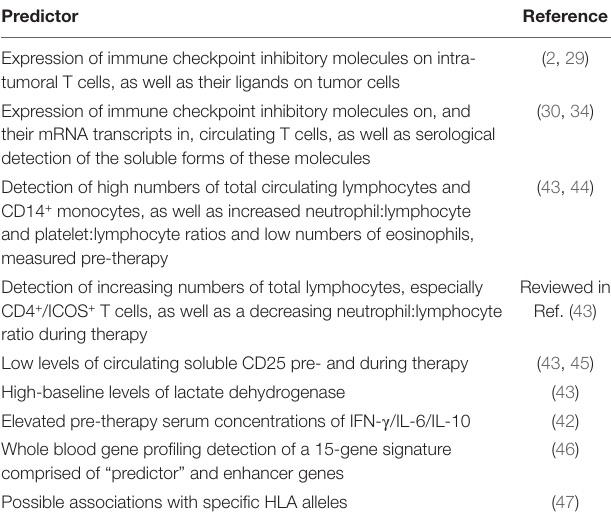
TABLe 2 | Measurable predictors of a favorable response to immune checkpoint inhibitor therapy. Predictor